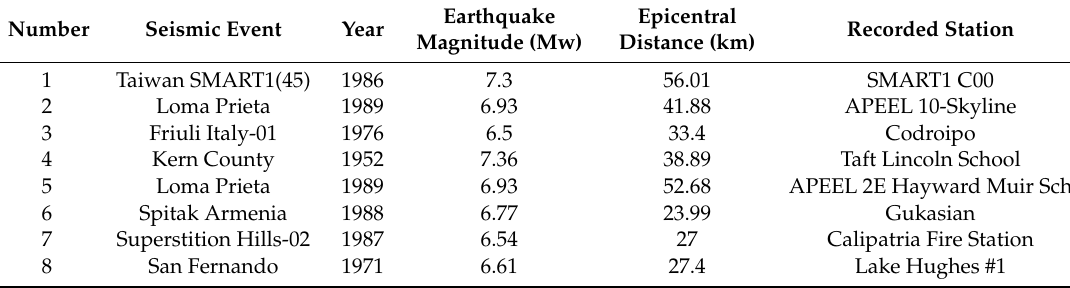
Figure 12. Acceleration spectrums of selected ground motions. Table 3. Basic information of selected ground motions.